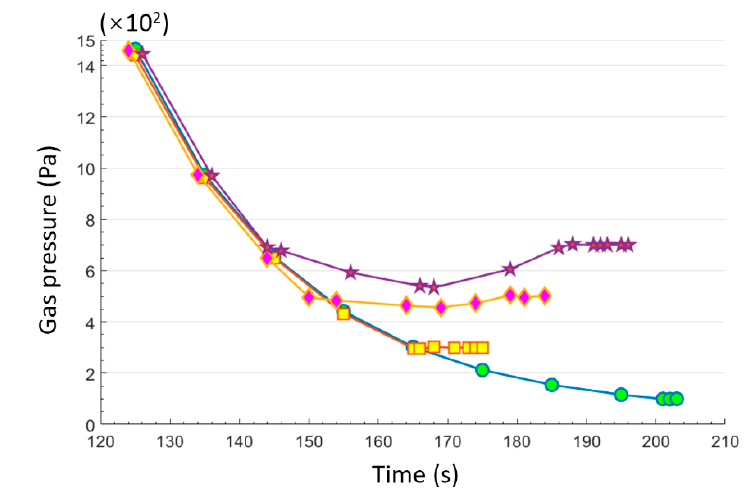
Figure 2. Typical curves of vacuum pressure with pump-down time.